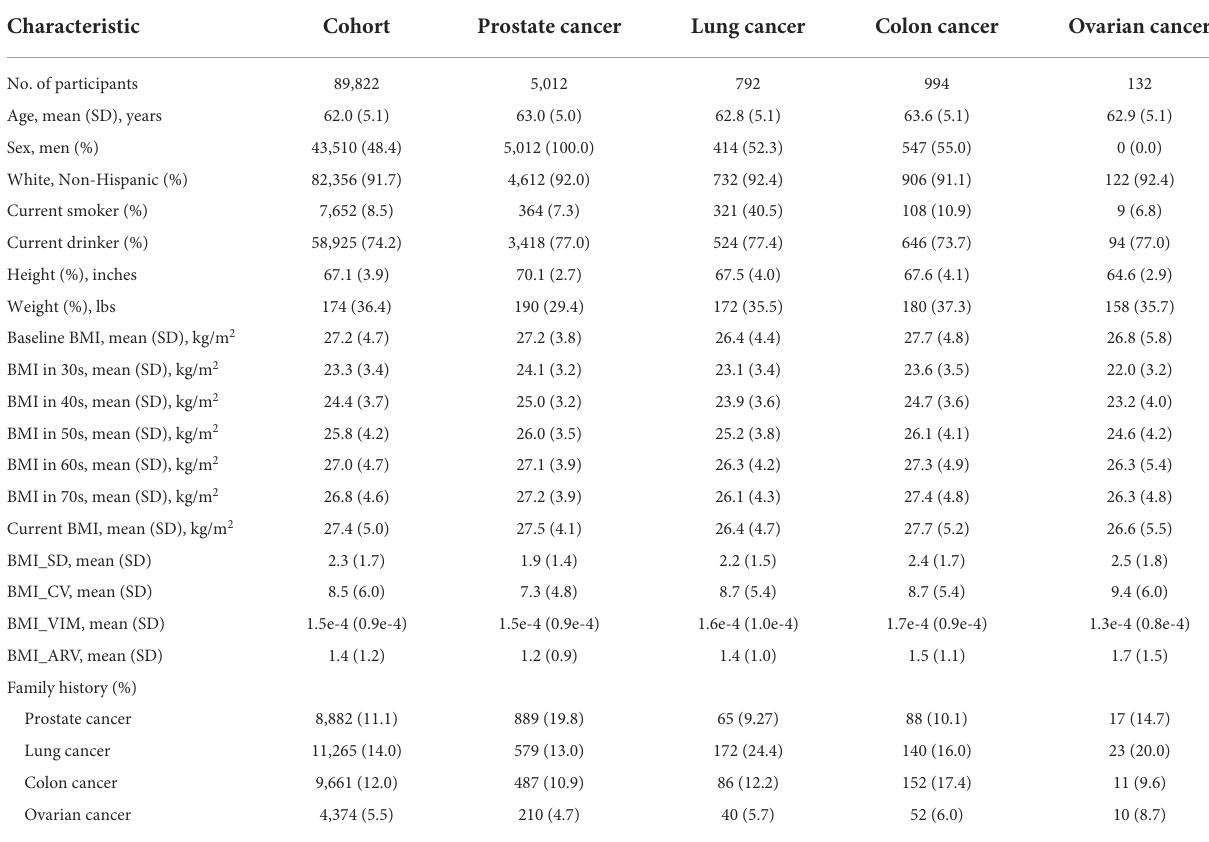
TABLE 1 Baseline characteristics of the study